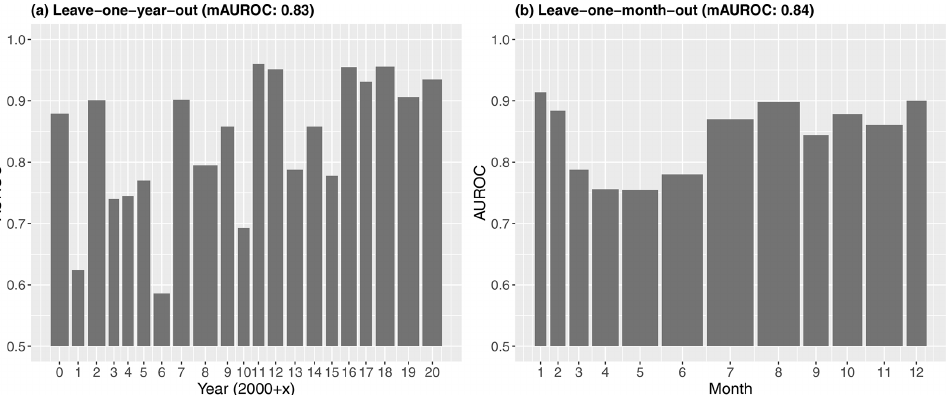
Figure 10. Leave-one-temporal-unit-out cross-validation. The AUROCs reveal, for each test year (a) or test month (b) , the predictive perfor- mance of a model that was trained on the remaining time periods (e.g. the months 1 to 11 were used to train a model whose prediction was tested with month 12 data). The bar width is proportional to the underlying test sample size (presences plus absences). The mAUROC at the top refers to the mean AUROC of all time periods.